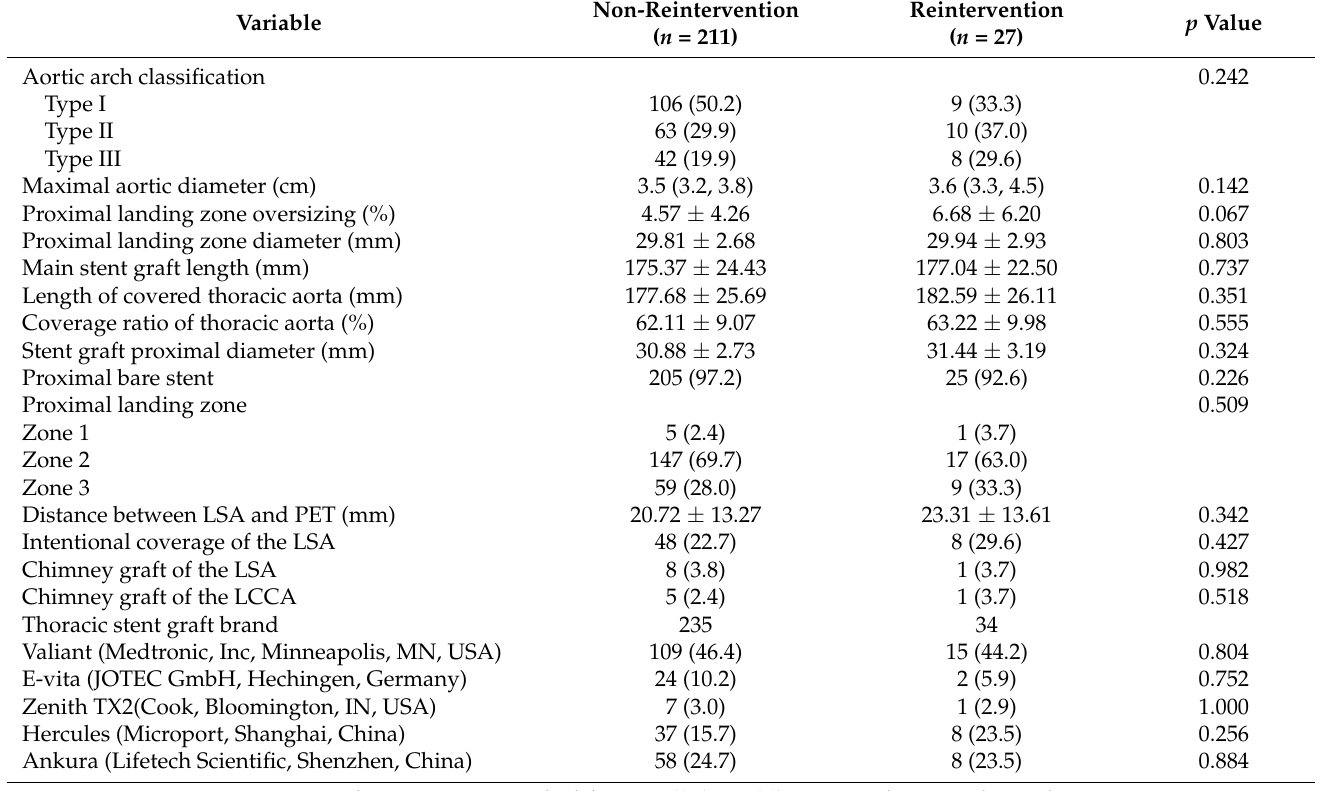
Table 2. Anatomical features of the thoracic aorta and details of the TEVAR procedure.